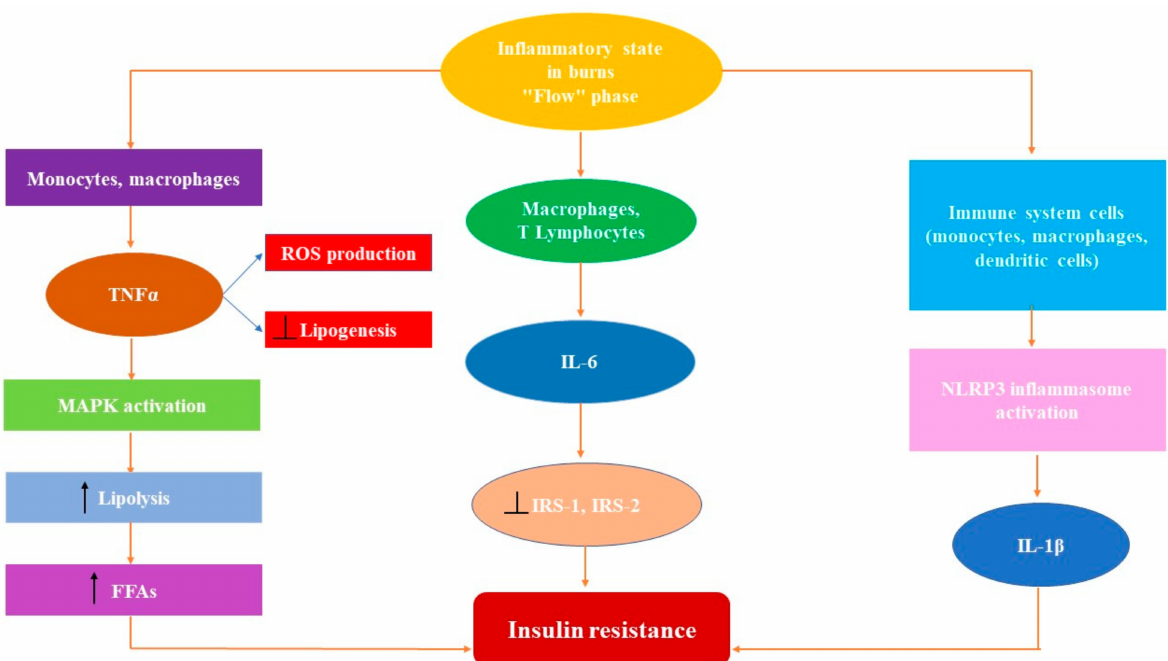
Figure 1. The inflammatory state in the "flow" phase of severe burns. Monocytes and macrophages secrete the tumor necrosis factor- α (TNF α ), leading to overproduction of reactive oxygen species (ROS) and inhibition of lipogenesis. Moreover, increased TNF α levels lead to mitogen activation of the protein kinase (MAPK), resulting in increased lipolysis and the release of a higher amount of free fatty saturated acids (FFAs). IL-6 is released by T lymphocytes and macrophages, blocking insulin receptor substrates 1 and 2 (IRS-1, IRS-2). Immune system cells stimulate the release of IL-1 β by the NLRP3 inflammasome. The augmented release of all three proinflammatory cytokines contributes to insulin resistance. “ ” shows an increase; “ ” indicates an inhibitory